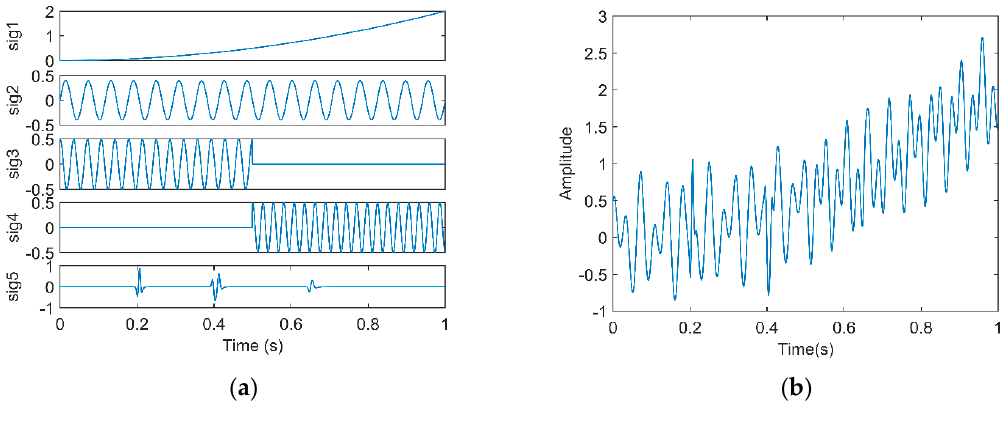
Figure 1. ( a ) Subsignals; and ( b ) synthetic signal.